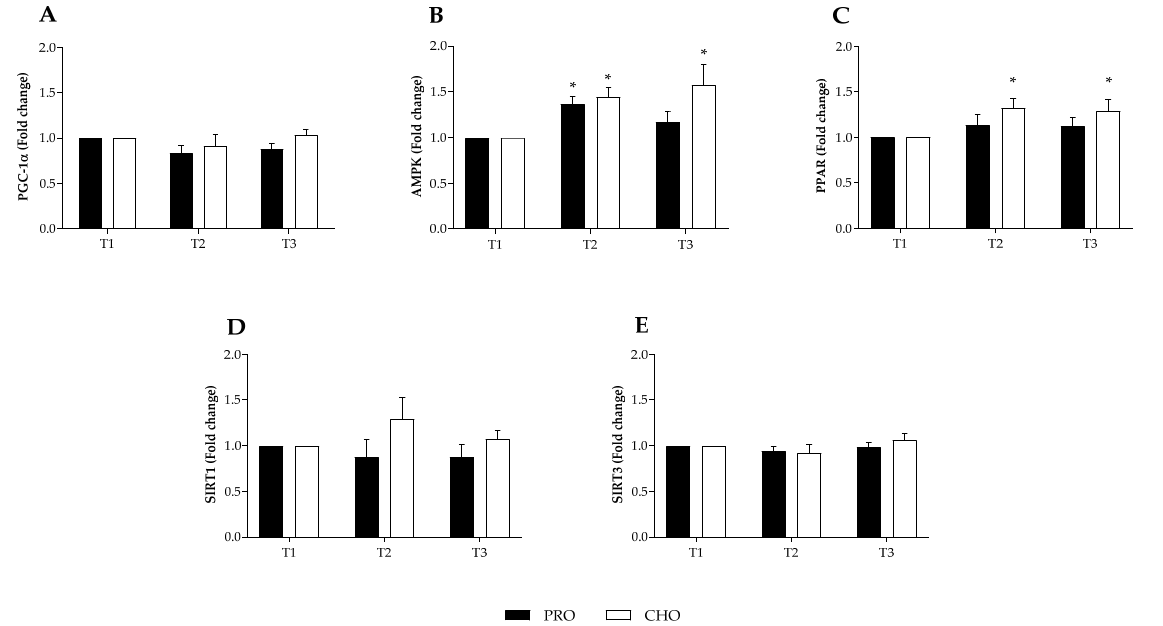
Figure 1. mRNA response (fold change) to habitual and intervention diet phases in combination with endurance training. Habitual dietary intake in first (T1) and third (T3) week. Intervention phase (T2) consisting of either high protein (PRO) or high carbohydrate (CHO) intake. mRNA expression of PGC-1 α ( A ), AMPK ( B ), PPAR ( C ), SIRT-1 ( D ), and SIRT-3 ( E ). *Denotes significantly different within group from T1 ( p < 0.044).